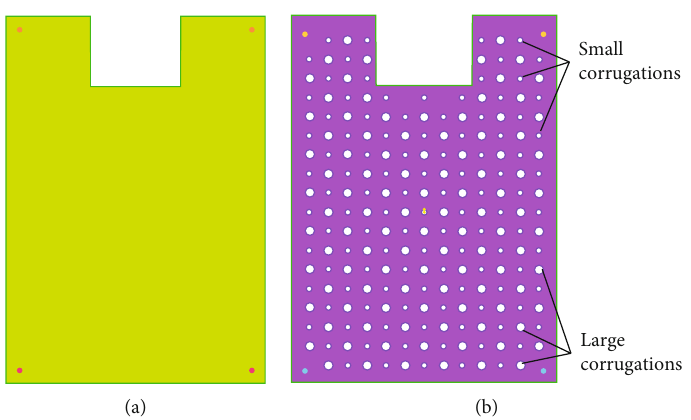
Figure 4: The metal sheet with smooth surface (a) and metal sheet with corrugations